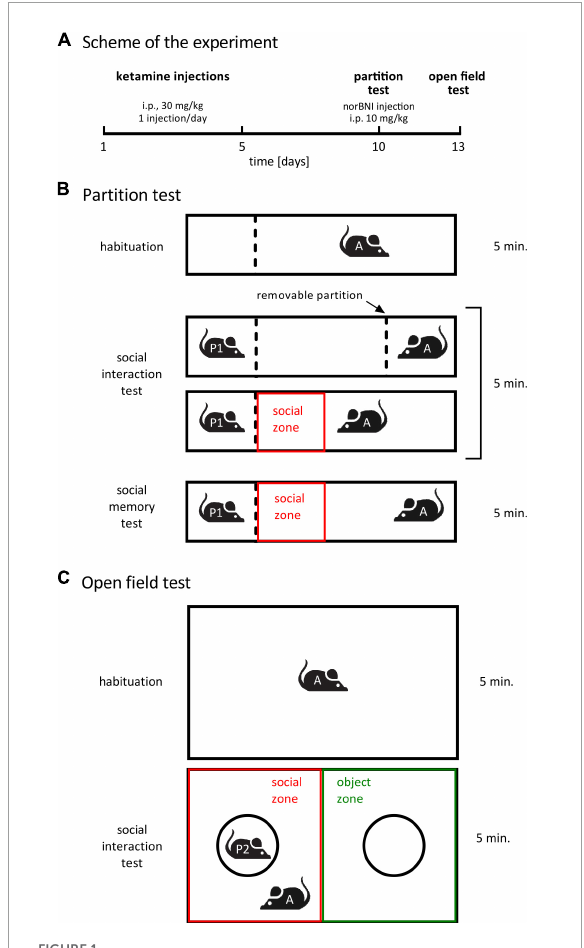
FIGURE1 Treatment schedule and behavioral paradigms. (A) A summary of the treatment schedule. norBNI indicates norbinaltorphimine. (B) A scheme of the partition test. The dotted lines represent a transparent perforated Plexiglas wall. The red box shows the area that was designated as social interaction zone during video analysis. “A” stands for “actor” (subject animal), “P” stands for “partner”. (C) A summary of the open field test. The circles represent wire cups. The red and green rectangles represent, respectively, the social zone and the object zone during video